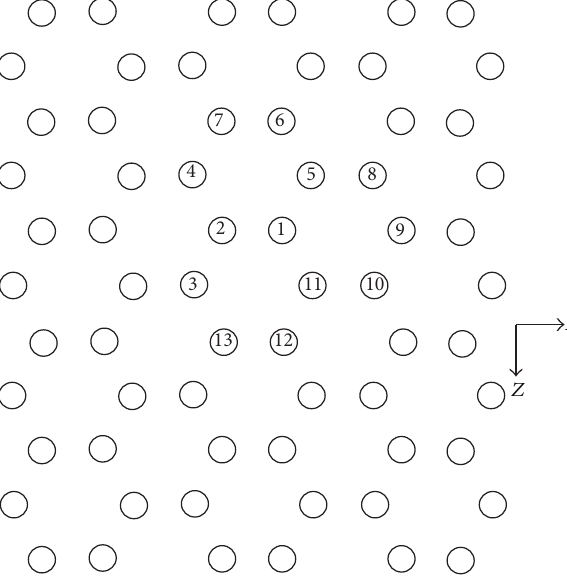
Figure 10: The two-dimensional PBGS 9 × 9 resonant cavity model with a cross structure in the center.